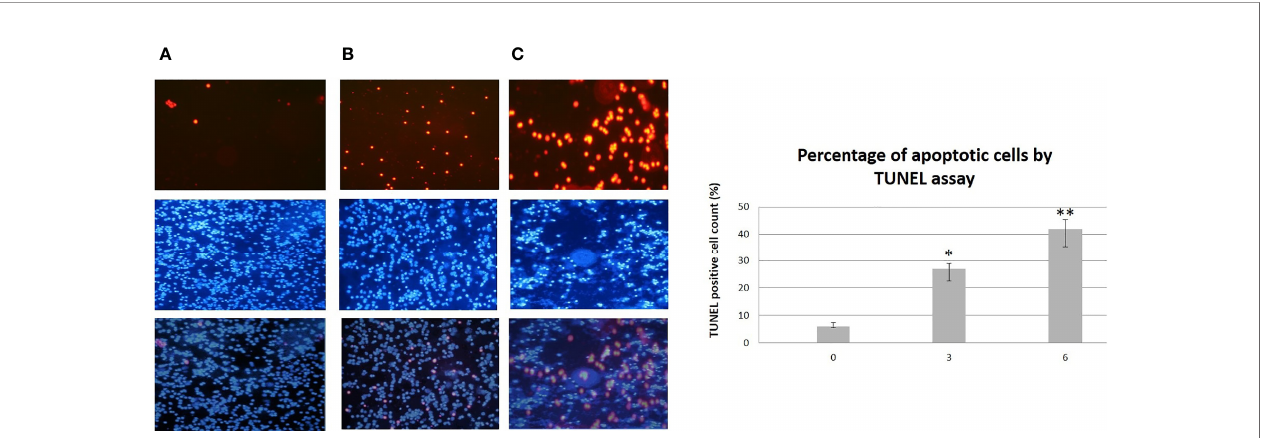
FIGURE 5 | TUNEL Assay (top) performed on isolated PMBC from patients with CLL during the dietary intervention DI2 with High OC/OL - EVOO. (A) Baseline. (B) 3 months of dietary intervention. (C) 6 months of dietary intervention. DAPI staining (middle) and overlay (bottom) are also illustrated. The data in the histograms are the mean ± SD of 22 different experiment subjects. Data were compared using the unpaired two-tailed t-test. Signi fi cant difference between the time points of the dietary intervention at p <0.05 (*0 – 3, **3 – 6 and 0 – 6) is indicated. For each subject each experiment was performed